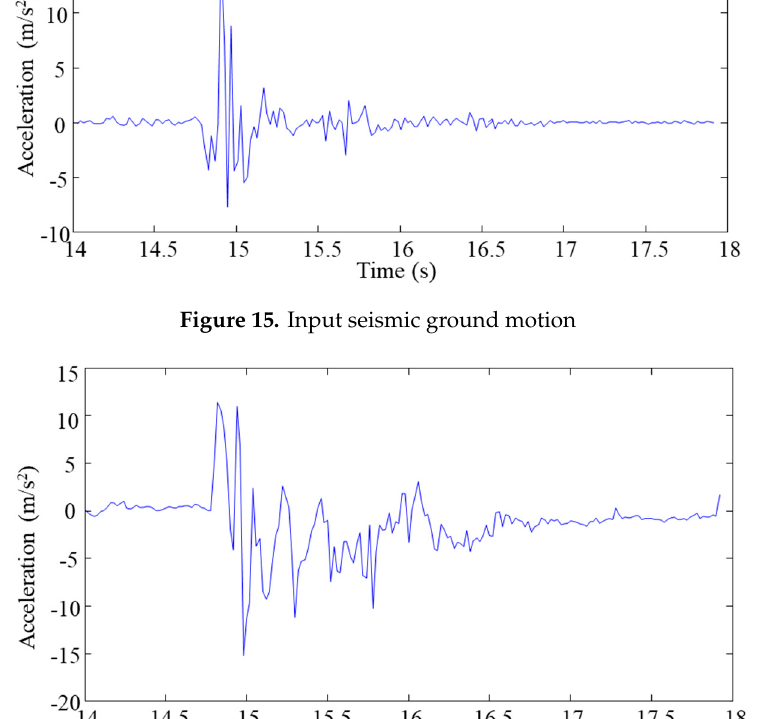
Appl. Sci. 2019 , 9 , x FOR PEER REVIEW Figure 16. The acceleration response of the top layer. Figure 16. The acceleration response of the top layer. Figure 16. The acceleration response of the top layer.